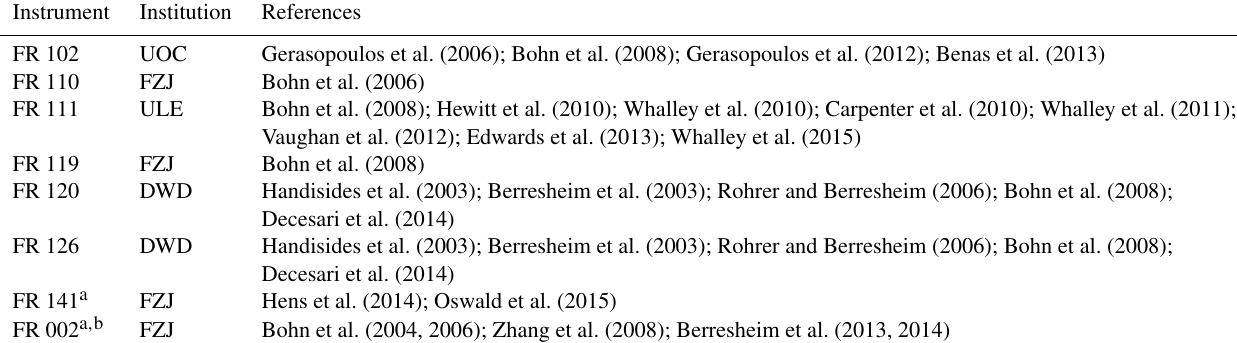
Table 1. j (O 1 D) filter radiometers investigated and modified within this work (instrument number, institution and references). Abbreviations: